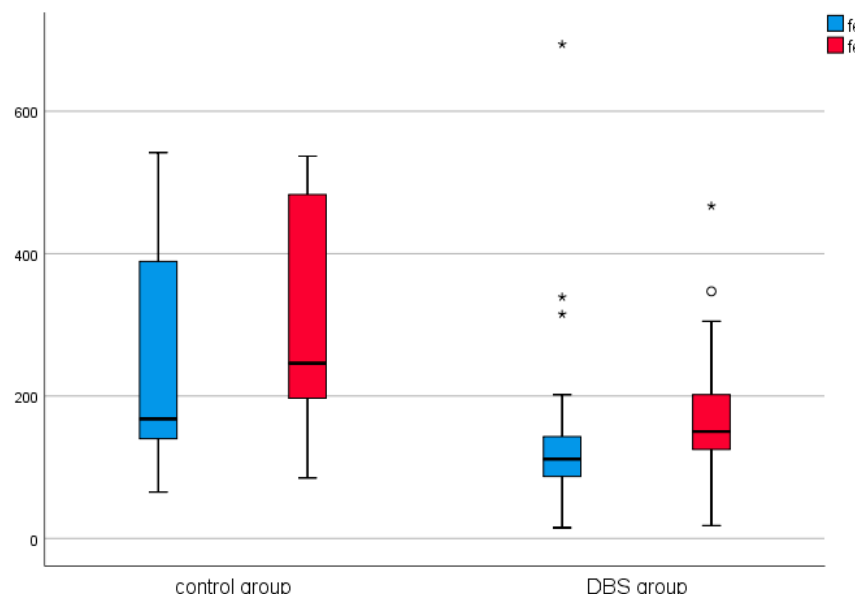
Figure 2. Effect of lesional surgery and DBS on ferritin levels (ng/mL). (°—outliers ≦ 3SD, *—outliers > 3SD).